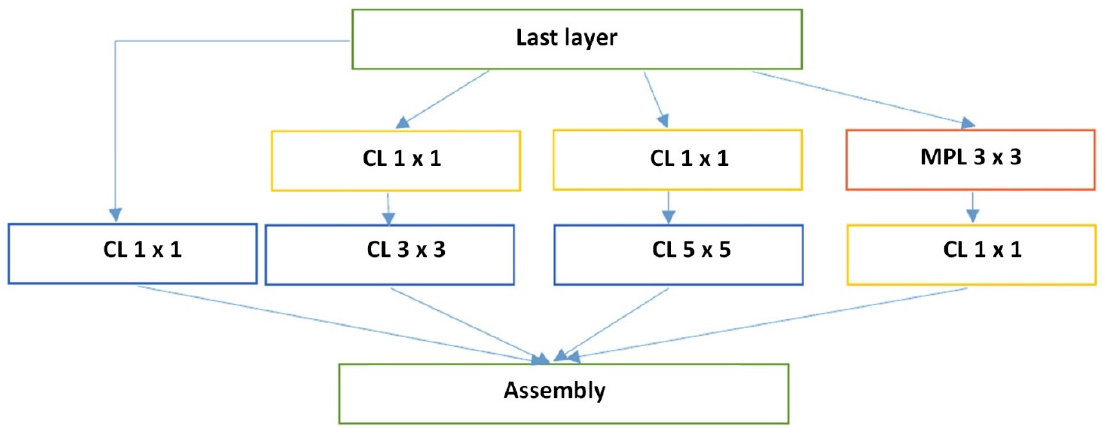
Figure 11. Inception module in GoogleNet. CL is the convolution layer and MPL is the maximum pooling layer. Dimensionality reduction layers are depicted in yellow, the maximum pooling layer is depicted in red, and the layers in the convolution operations are shown in blue.